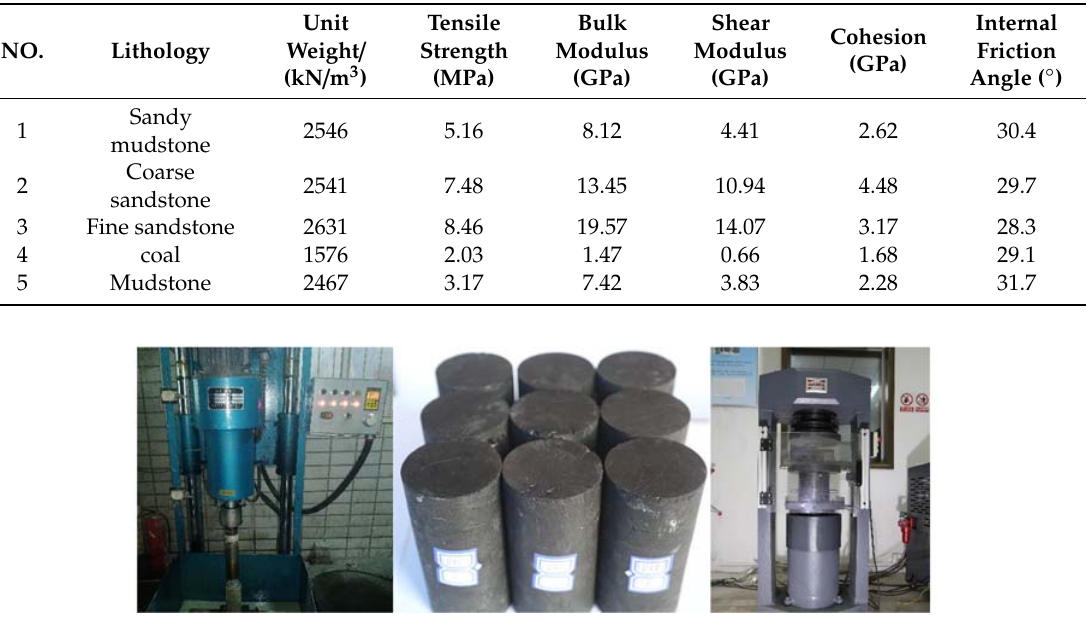
Table 2. Mechanical parameters.